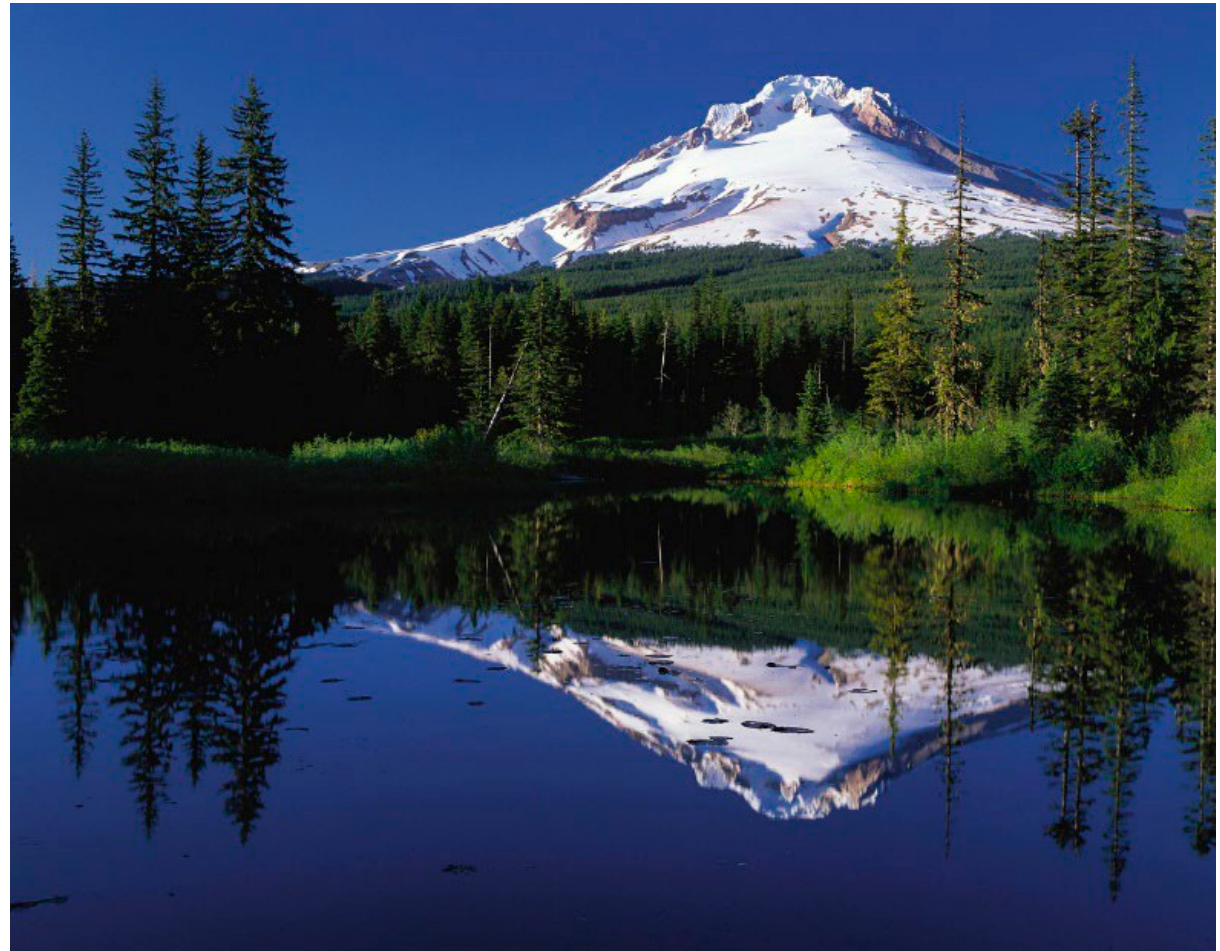
Figure 2. Water Mirror Approach: Just like the surface of the lake reflects its surroundings, the water on a molecular level is behaving like a mirror – its spectrum reflecting all the molecular components and influences of surrounding